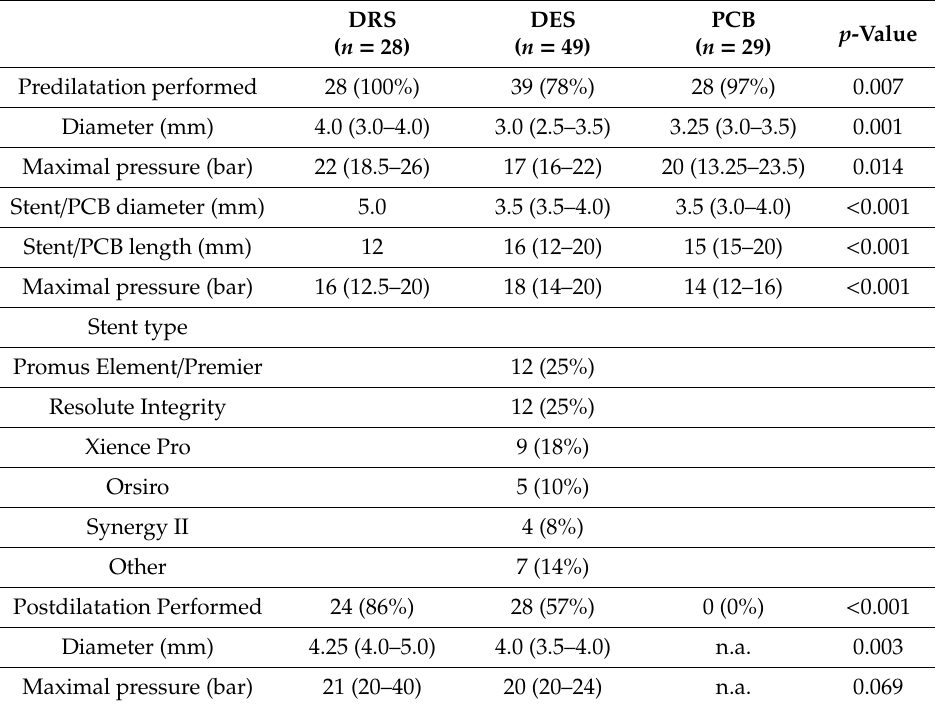
Table 3. Procedural Characteristics of the